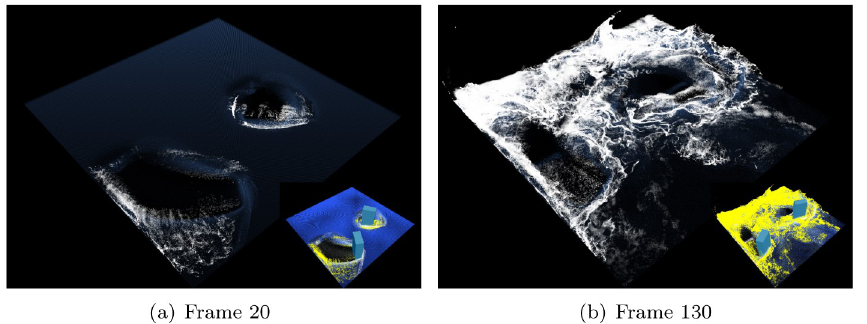
Fig 13. Foam effects with our method in two rotating boxes (inset image: Simulation view). (a) Frame 20, (b) Frame 130.